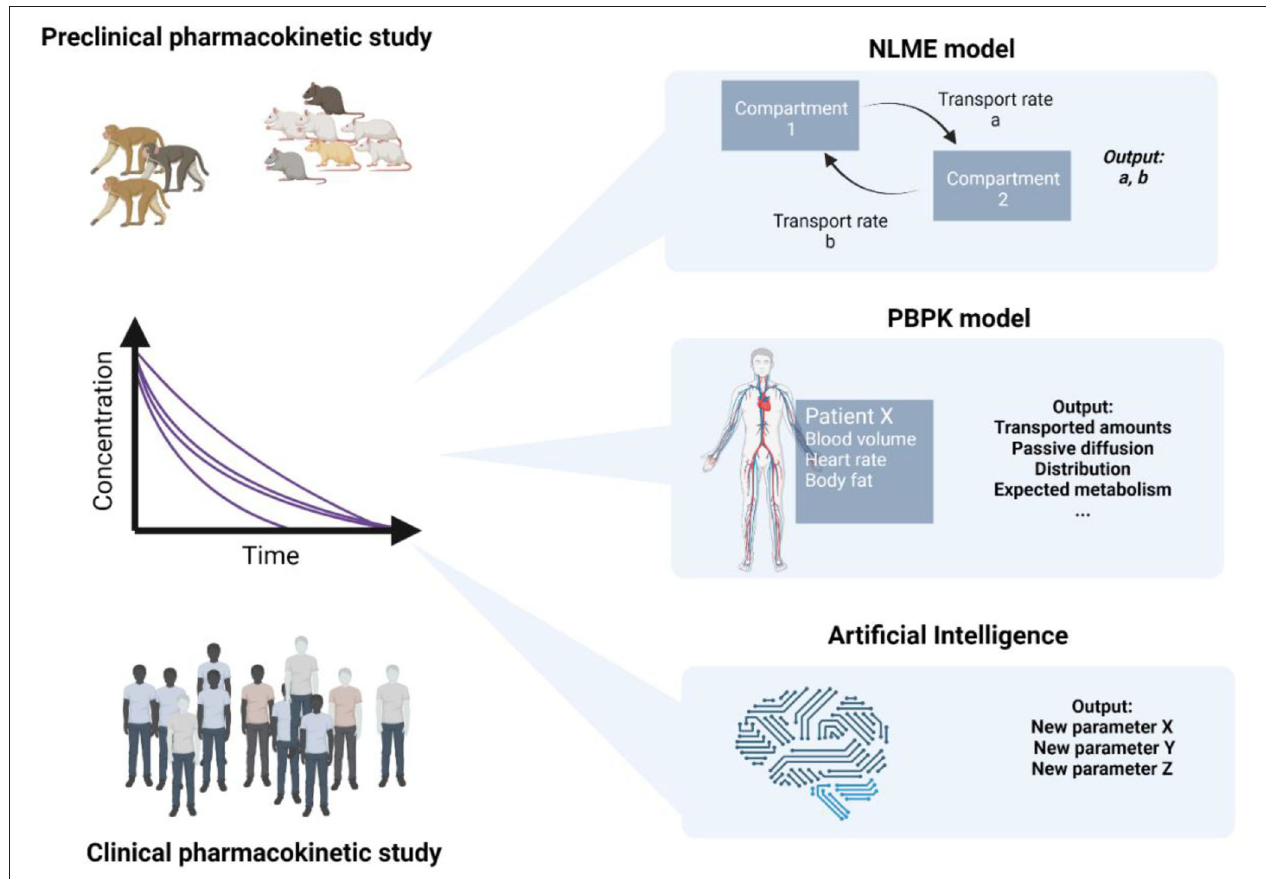
FIGURE 3 | Illustration of the evaluation of pharmacokinetic data using NLME and PBPK models as well as ANNs. Created with